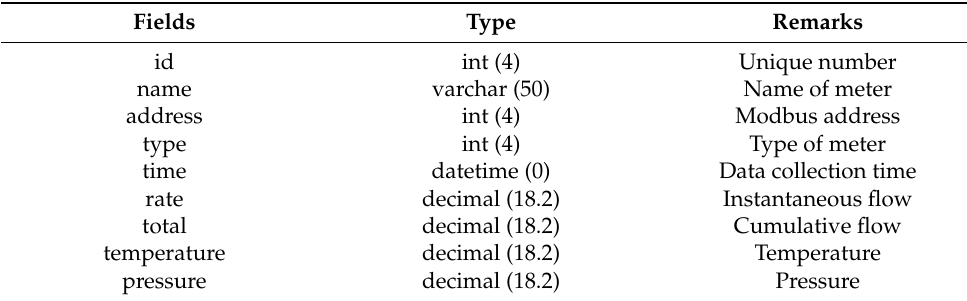
Figure 3. Connections between entities. Table 1. Design of fields in data